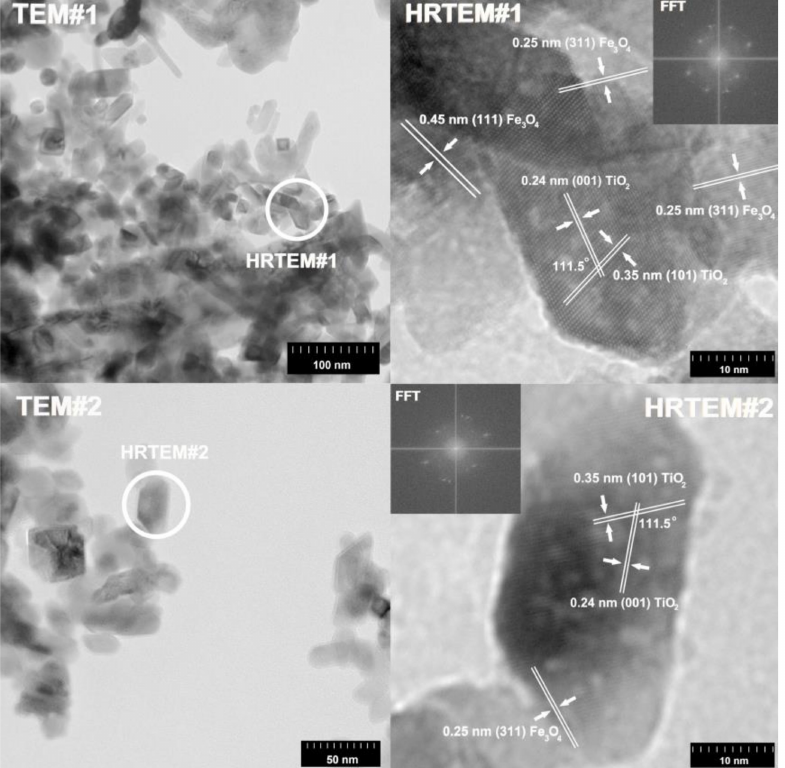
Figure 4. TEM, HR-TEM, and FFT results for the (7)TiO 2 -(3)Fe 3 O 4 sample.